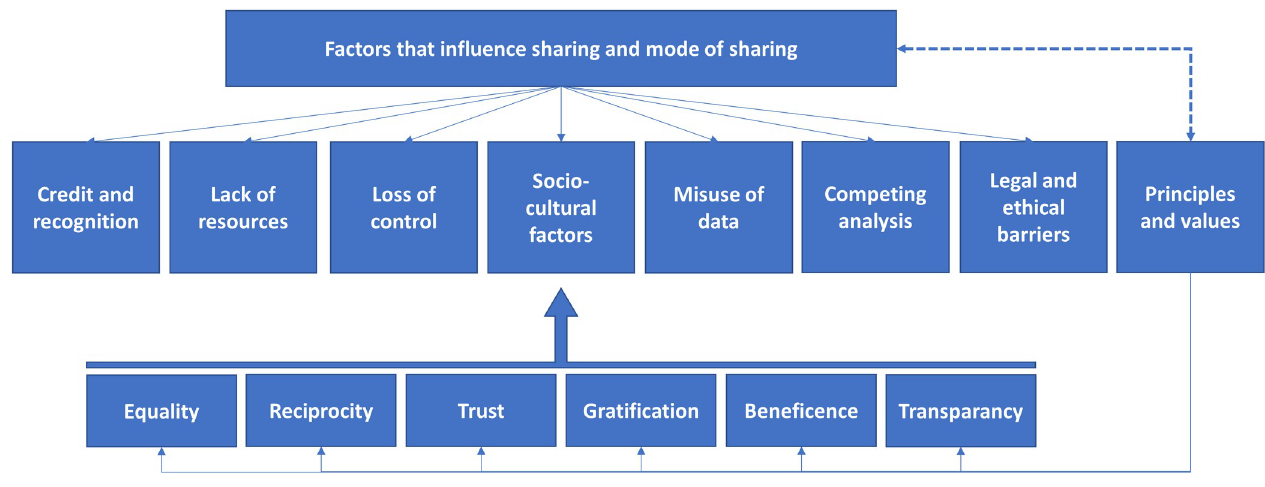
Fig 1. Coding scheme derived from interview data.